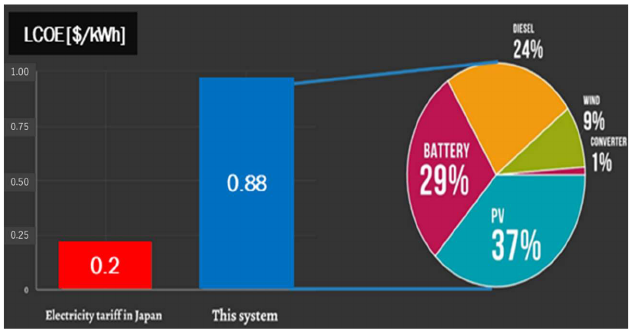
Figure 21. Estimated levelized cost of electricity (LCOE) of the proposed microgrid.